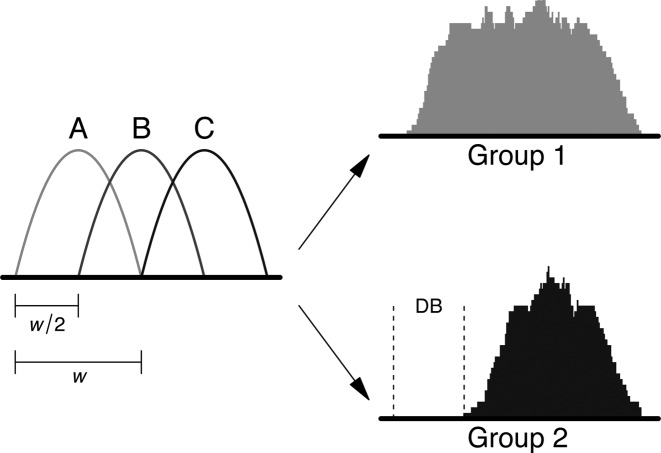
Diagram of the simulation design for complex DB events. The binding profile is comprised of subintervals A, B and C, each of width \documentclass[12pt]{minimal}
\usepackage{amsmath}
\usepackage{wasysym}
\usepackage{amsfonts}
\usepackage{amssymb}
\usepackage{amsbsy}
\usepackage{upgreek}
\usepackage{mathrsfs}
\setlength{\oddsidemargin}{-69pt}
\begin{document}
}{}$w$\end{document} and offset from each other by \documentclass[12pt]{minimal}
\usepackage{amsmath}
\usepackage{wasysym}
\usepackage{amsfonts}
\usepackage{amssymb}
\usepackage{amsbsy}
\usepackage{upgreek}
\usepackage{mathrsfs}
\setlength{\oddsidemargin}{-69pt}
\begin{document}
}{}$w$\end{document}/2. DB is introduced by dropping one or two subintervals in one of the groups, e.g. subinterval A is dropped in group 2, above.